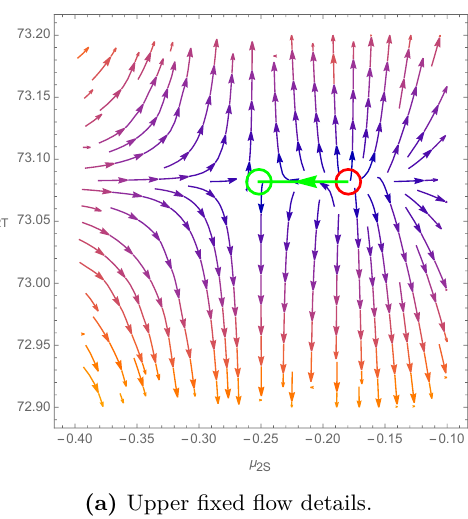
(a) Upper fixed flow details. (b) Lower fixed flow details. Figure 3. Close-ups of double trace flows for M = 425 with fixed flows marked by circles. Two almost vertical separatrices connecting the upper and lower fixed flows have not been